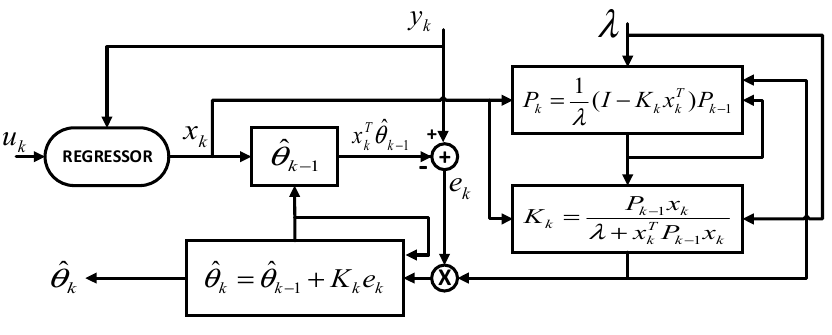
Figure 10. Recursive least squares algorithm.